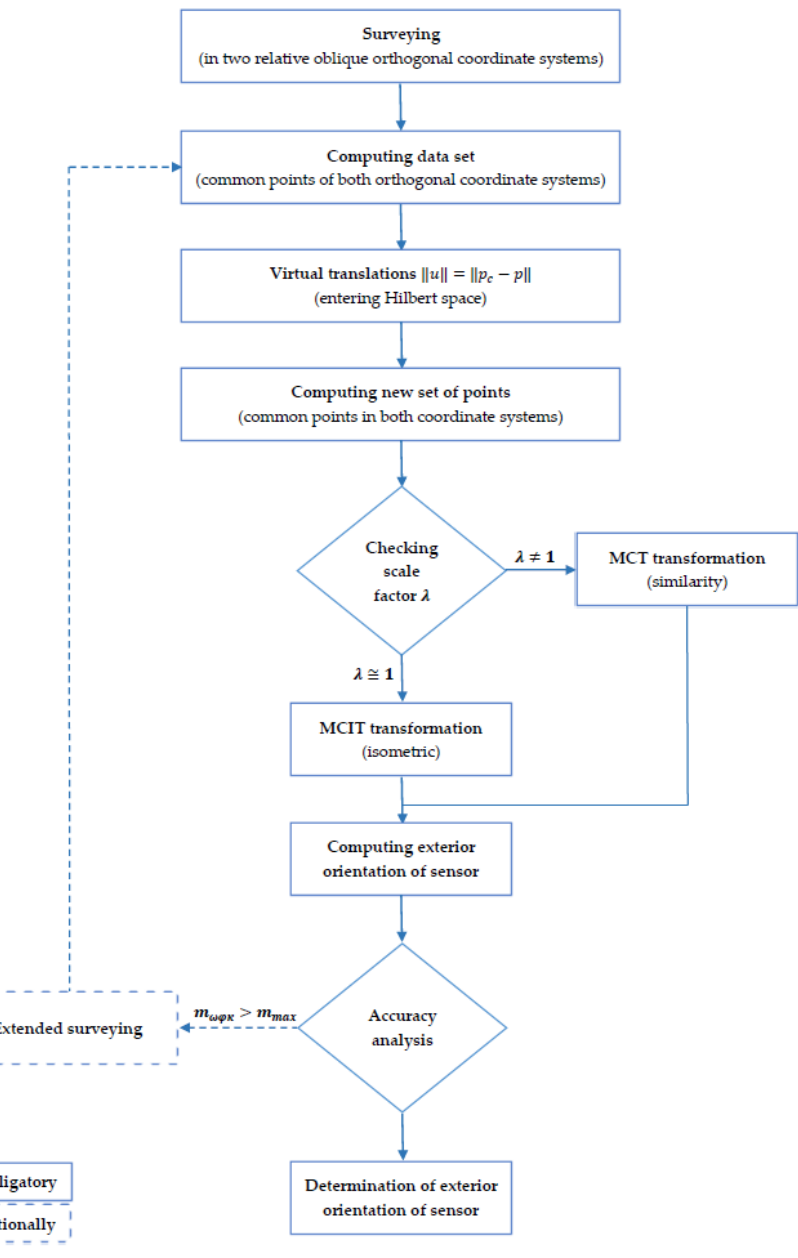
Figure 2. Algorithm of determination of exterior orientation of sensors.